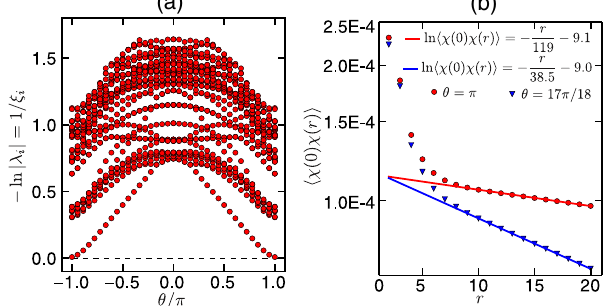
FIG. 5. (a) The transfer matrix spectrum of the kagome Heisenberg model in the S z ¼ 0 sector versus the twist angle θ . Here, we have the YC8-2 cylinder, J ¼ 0 . 05 , and bond 2 dimension m ¼ 6000 . (b) Correlation function of the scalar chirality h χ ð 0 Þ χ ð r Þi at θ ¼ π and 17 π = 18 . The correlation lengths from fitting h χ ð 0 Þ χ ð r Þi are ξ ¼ 119 ( θ ¼ π ) and ξ ¼ 38 . 5 ( θ ¼ 17 π = 18 ), which are virtually identical to the correlation lengths obtained from the transfer matrix ξ ¼ 121 and ξ ¼ 39